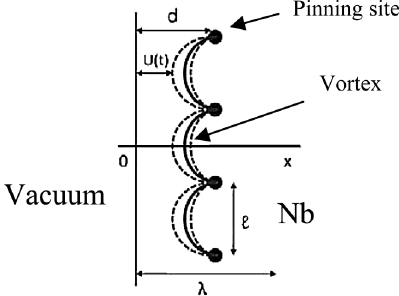
FIG. 3. Vortex pinned by a chain of defects near the surface. The solid line shows the equilibrium vortex shape due to com- petition of pinning and image attraction forces. The dashed lines show instantaneous vortex profiles for B ð t Þ ¼ B (cid:2) B , between which the vortex line oscillates. The figure is p taken from Ref.